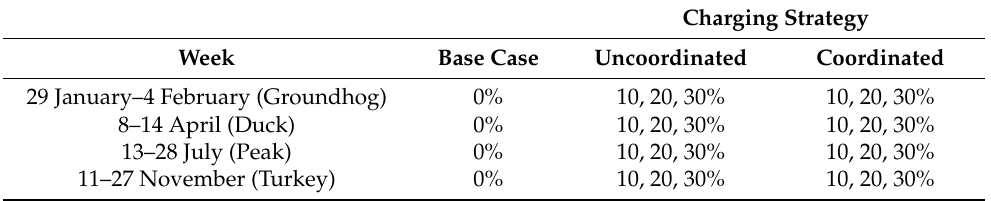
Table 5. Enumeration of the cases considered in the analysis of the effects of EV charging in the RTS-GMLC.